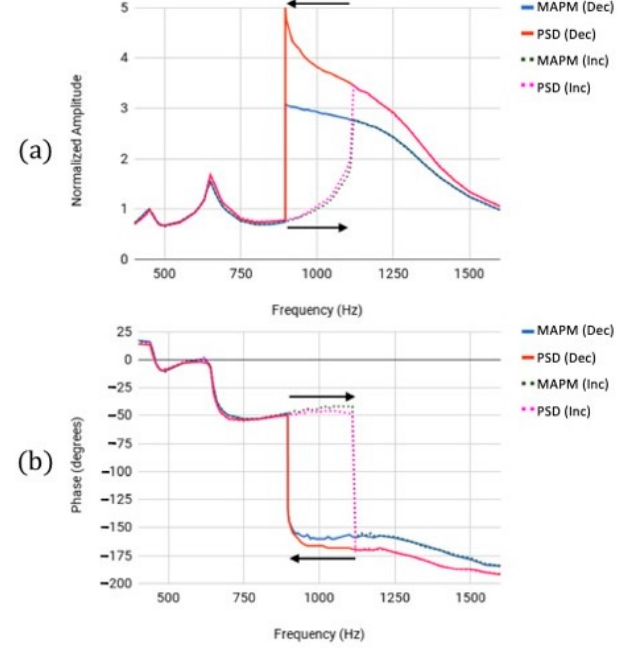
Figure 3. ( a ) Normalized MEMS amplitude frequency responses measured by the MAPM (blue/green) and PSD (red/magenta) for the high drive voltage case. The amplitude responses for the decreasing frequency scan (solid) for both sensors revealed peaks at 450.0 Hz and 650.0 Hz, and a sharp drop at 895.6 Hz. Amplitude responses for the increasing frequency scan (dashed) showed peaks at 450.0 Hz, 650.0 Hz, and 1120.0 Hz. ( b ) Phase responses measured by MAPM (blue/green) and PSD (red/magenta). Phase responses for the decreasing frequency scan (solid) showed sharp changes in phase at 450.0 Hz, 650.0 Hz, and 895.6 Hz. Both phase responses for the increasing frequency scan (dashed) showed steep phase gradients at 450.0 Hz, 650.0 Hz, and 1120.0